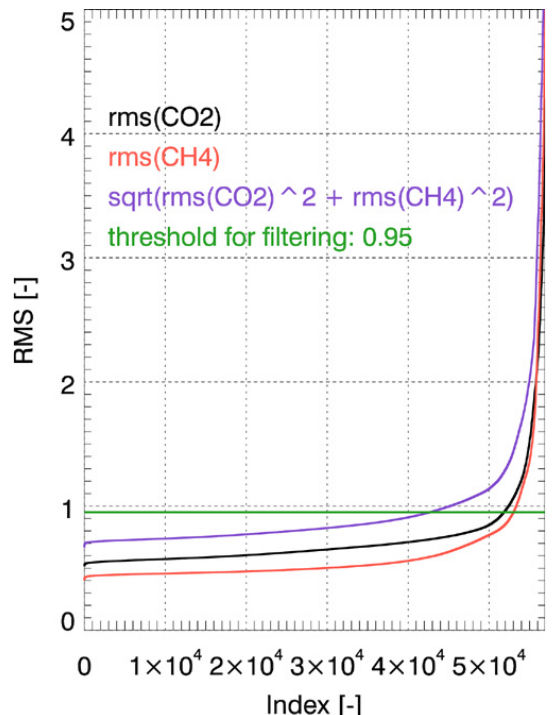
Fig. 7. Root mean square (rms) of the difference between fit and model for the dataset used for the inversion ordered by value. The green vertical line shows the filter threshold which was set to 0.95 for the